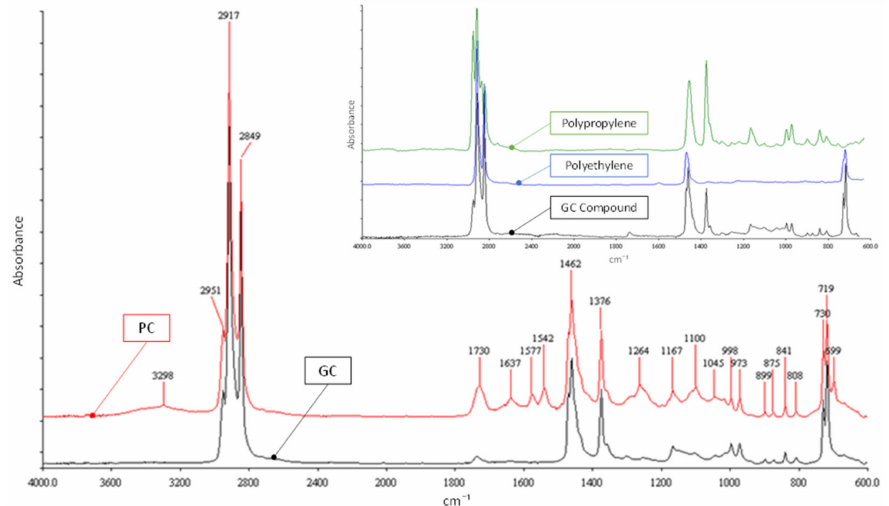
Figure 2. FTIR spectra of the compounds: GC (black line) and PC (red line). In inset: the compar- ison between GC (black line) and data available in the literature, related to PE (blue line) and PP (green